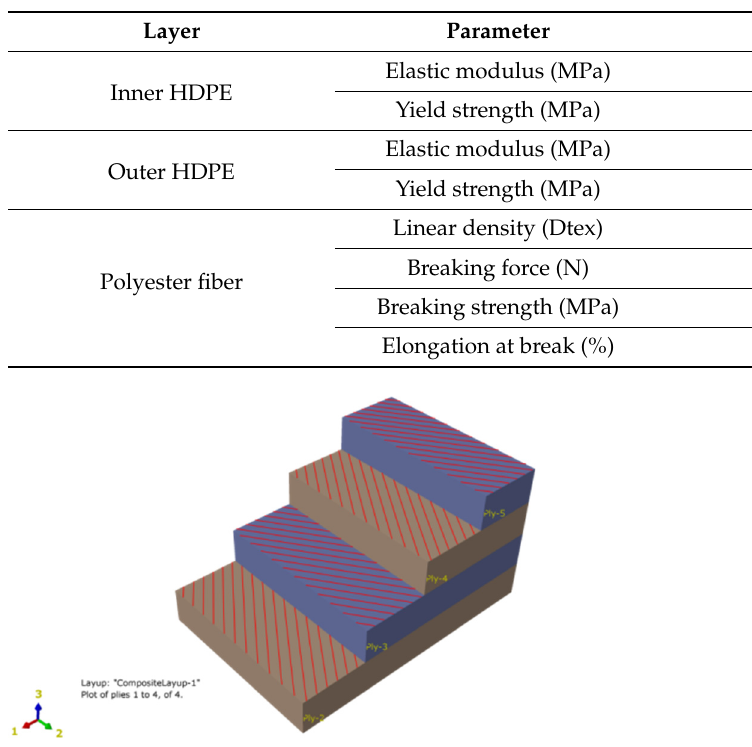
Table 2. Parameters of materials used in the RTP.